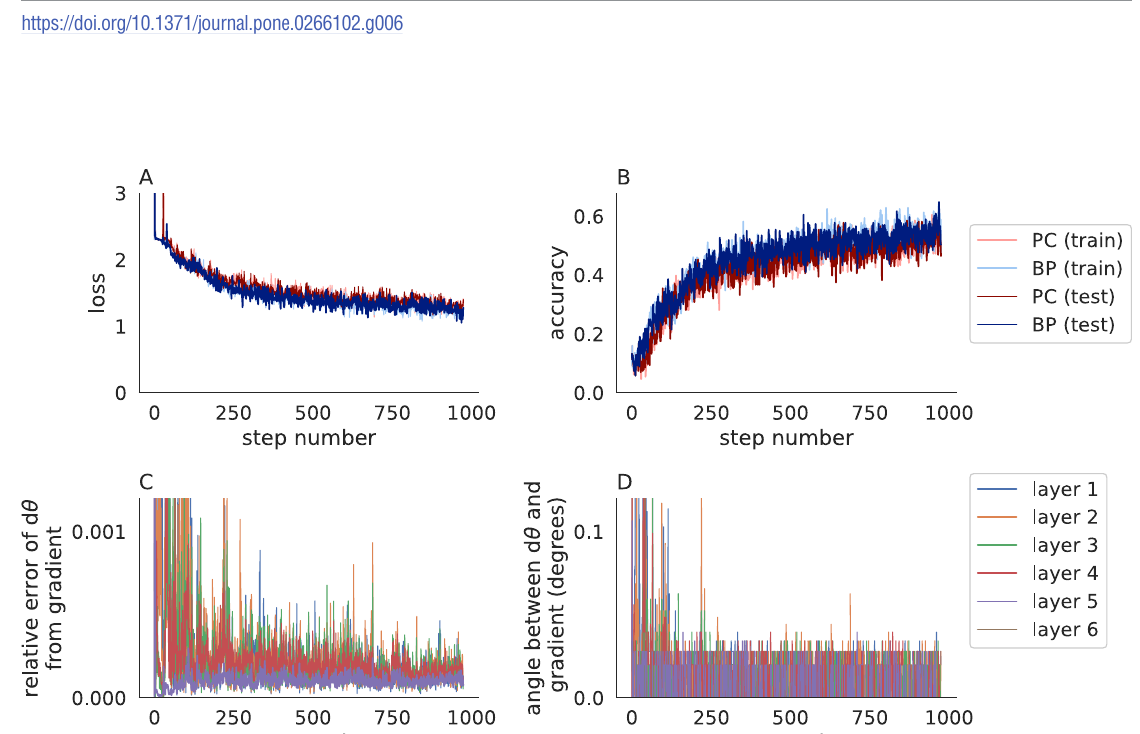
Fig 6. Predictive coding modified by the fixed prediction assumption with η = 1 compared to backpropagation in convolutional neural networks trained on MNIST. Same as Fig 3 except η = 1 and n = L . Predictive coding with the fixed prediction assumption approximates true gradients accurately when η = 1.